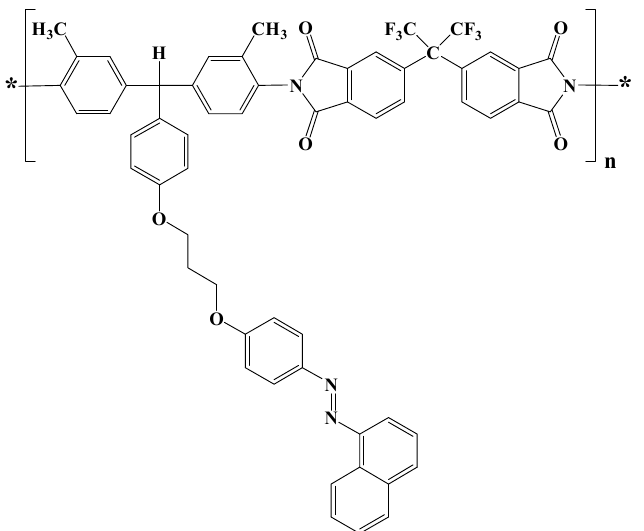
Figure 1. Chemical structure of the novel azo-naphthalene-based polyimide, AzoPI, used in this study.